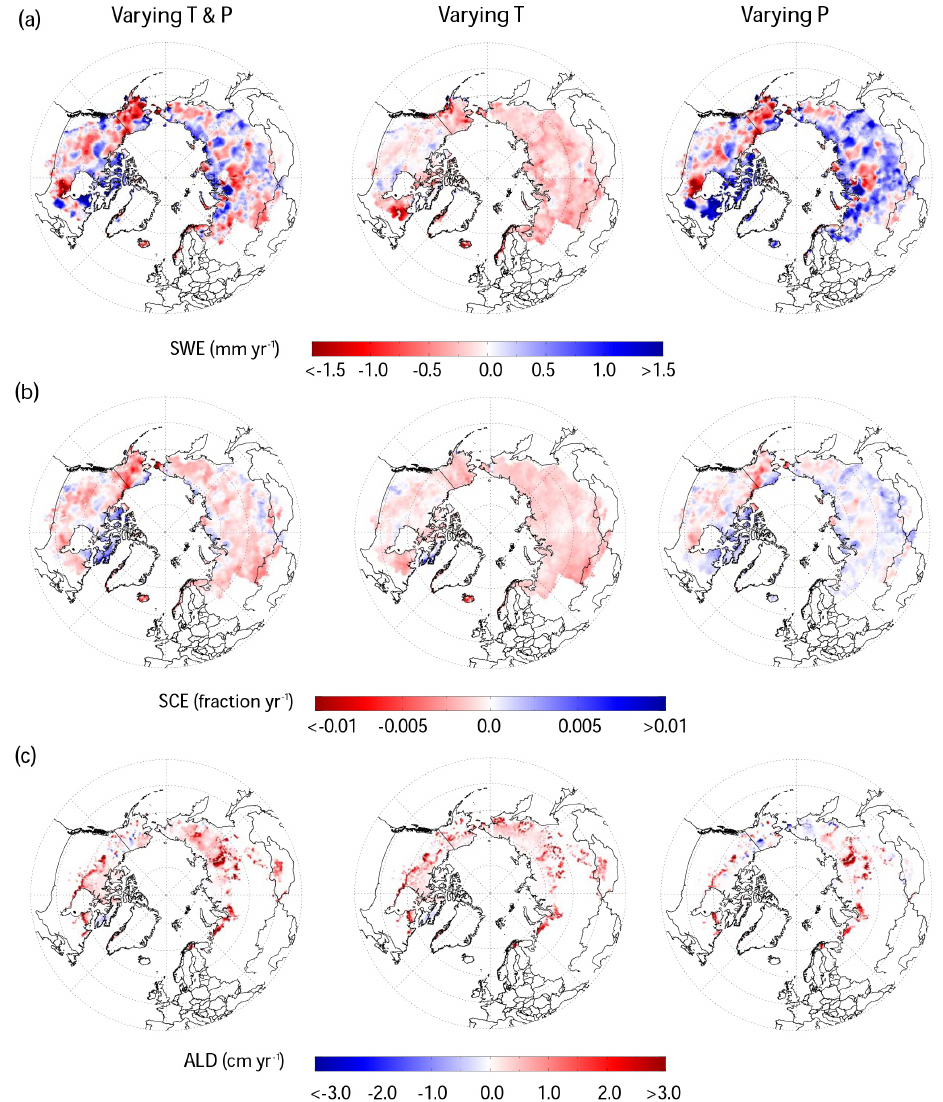
Figure 8. Simulated trends of (a) snow water equivalent (SWE), (b) snow cover extent (SCE) and (c) active layer depth (ALD) for the three model sensitivity experiments for the 1982 to 2010 period. For the sensitivity analysis, the model was driven using different surface meteorology data sets. The results based on model runs using varying temperature ( T ) and precipitation ( P ) are presented in the left column; the results based on model runs using varying T alone are shown in the middle column; and results based on model runs using varying P alone are shown in the right